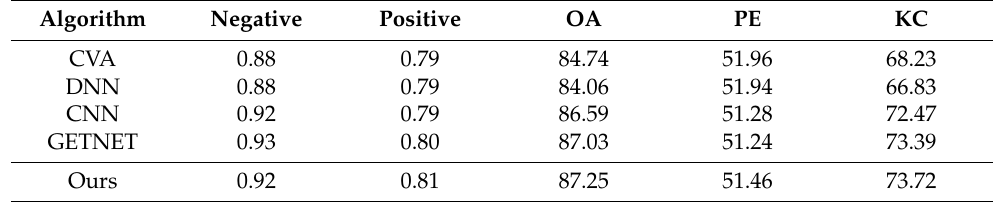
Figure 7. Comparison results of different algorithms on the Santa Barbara dataset. ( a ) Reference map. Table 4. Quantitative evaluation of experimental results of different methods on Santa Barbara